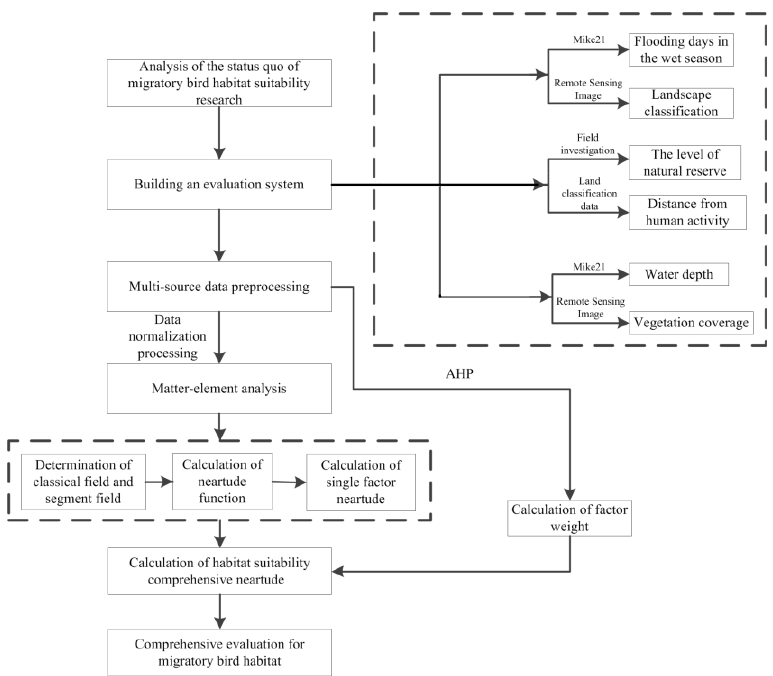
Figure 2. Schematic representation of the steps implemented to evaluate habitat suitability for migratory birds in Poyang Lake.